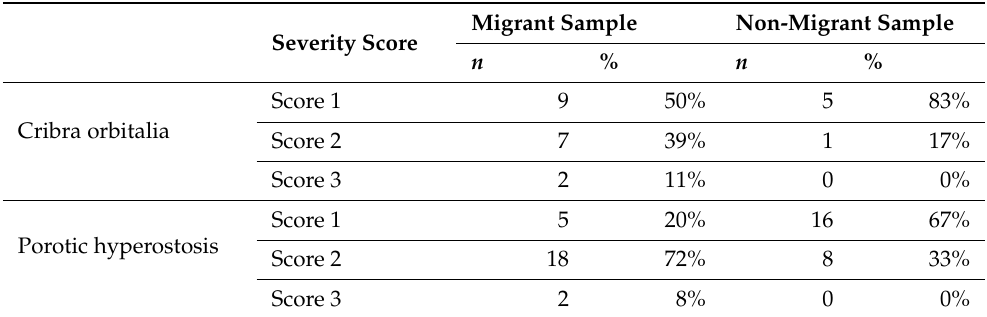
Table 4. Statistical analyses and p -values (significant p -values were bolded in the table).